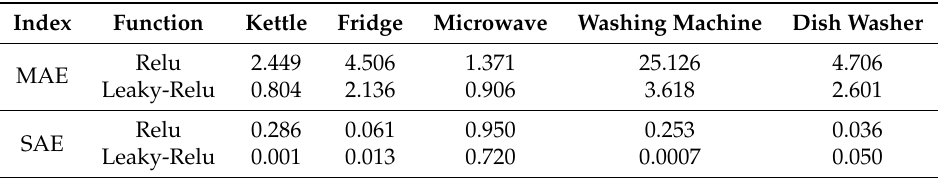
Table 6. Comparison of the activation function of Household 5 of the UK-DALE